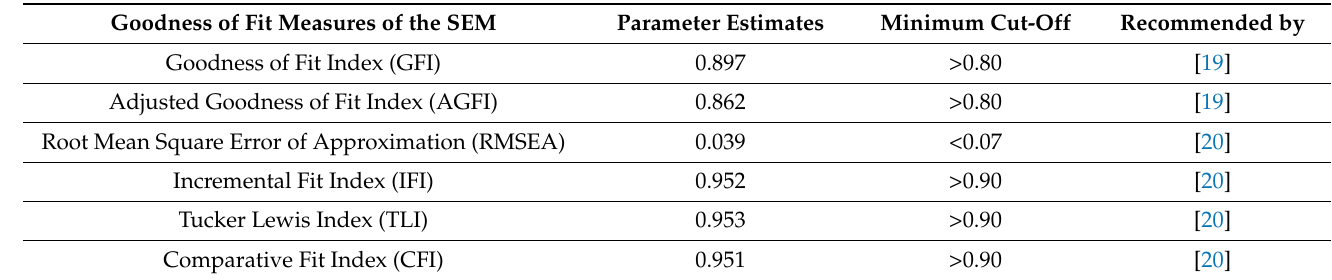
Table 5. Goodness of Fit and Parameter